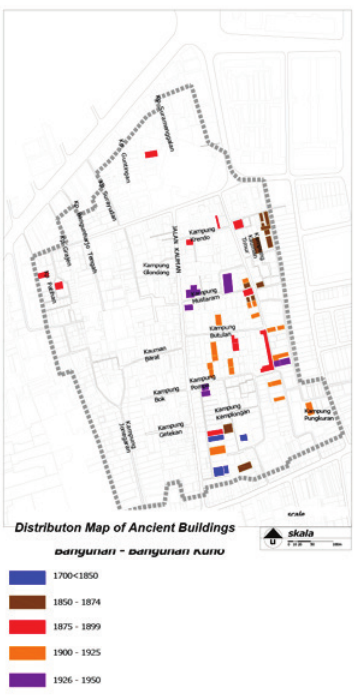
Figure 2. The spread of ancient houses which were built in 1800s period